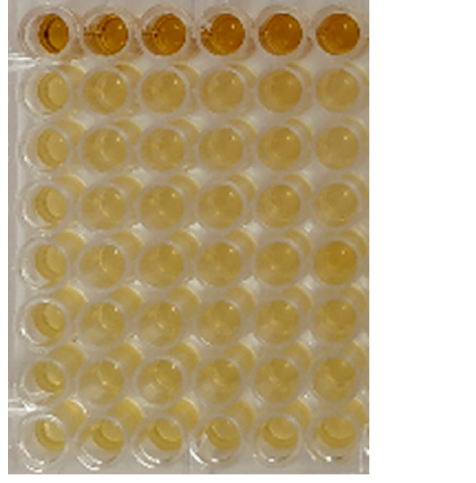
Figure 1. RGB images before and after the addition of resazurin (0.4 mg/mL). ( a ) The 1199 strain before the addition of resazurin (0.4 mg/mL); ( b ) 1199 strain after the addition of resazurin (0.4 mg/mL); ( c ) 1199B strain before the addition of resazurin (0.4 mg/mL) and ( d ) 1199B strain after the addition of resazurin (0.4 mg/mL).